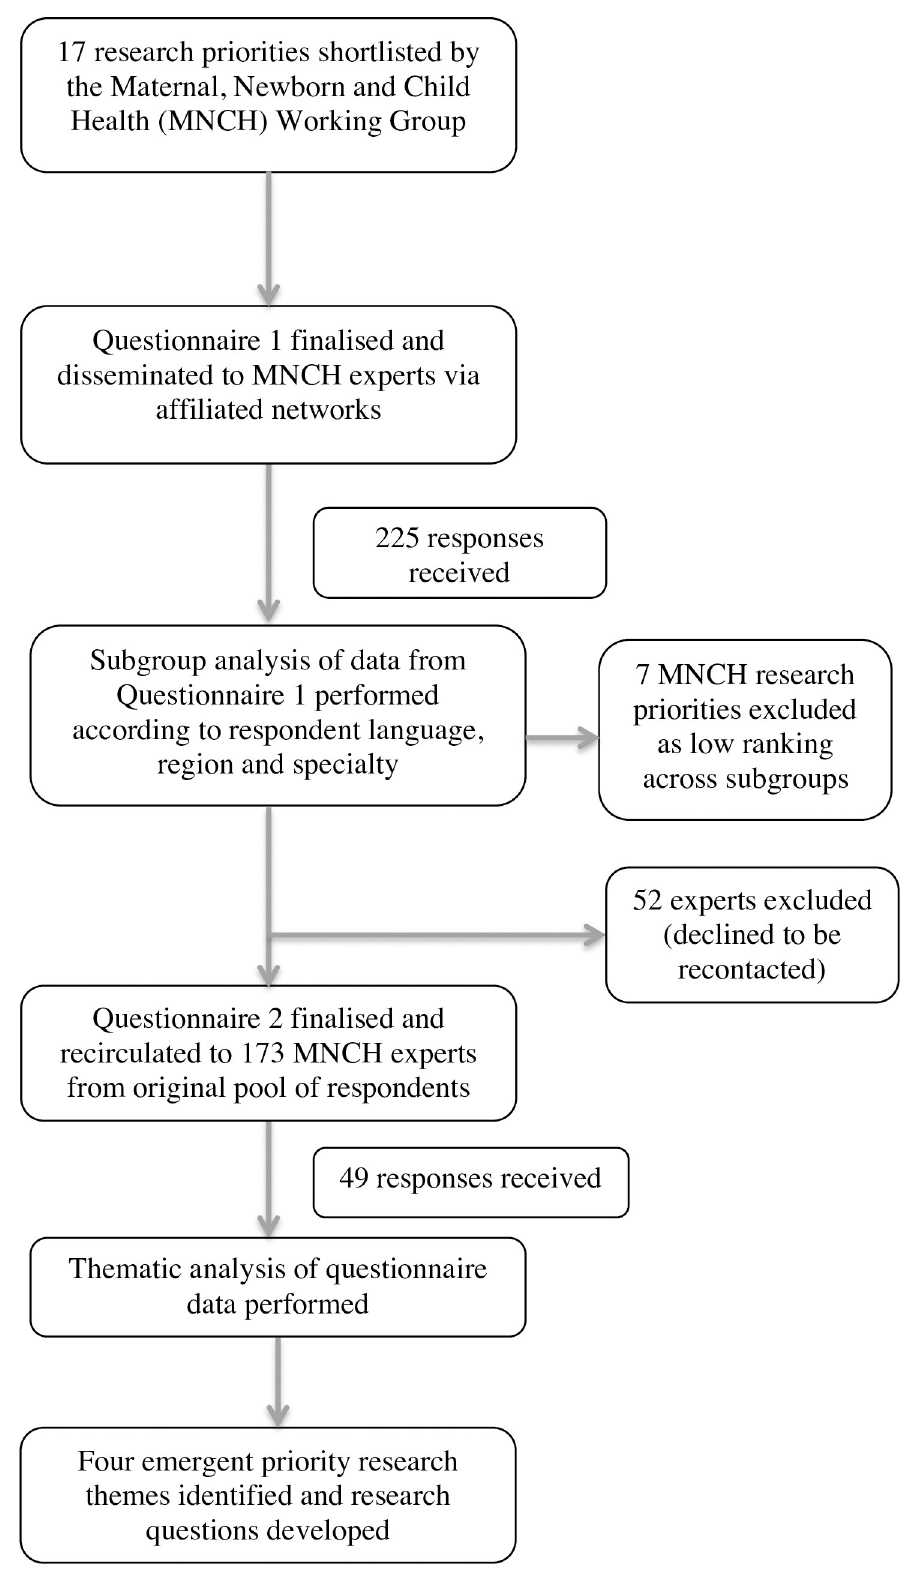
Fig 1. Overview of the modified Delphi method implemented for the development of the maternal, reproductive and child health COVID-19 priority research themes, October 2020–January 2021.